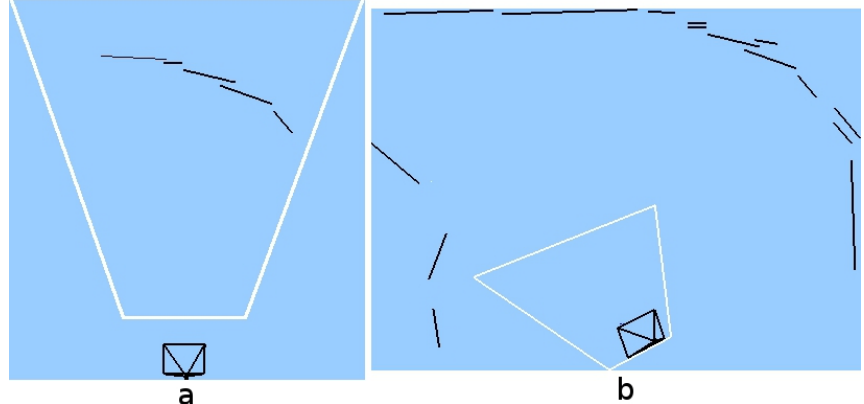
Figure 14. ( a ) Information in current field of view; ( b ) Short-term